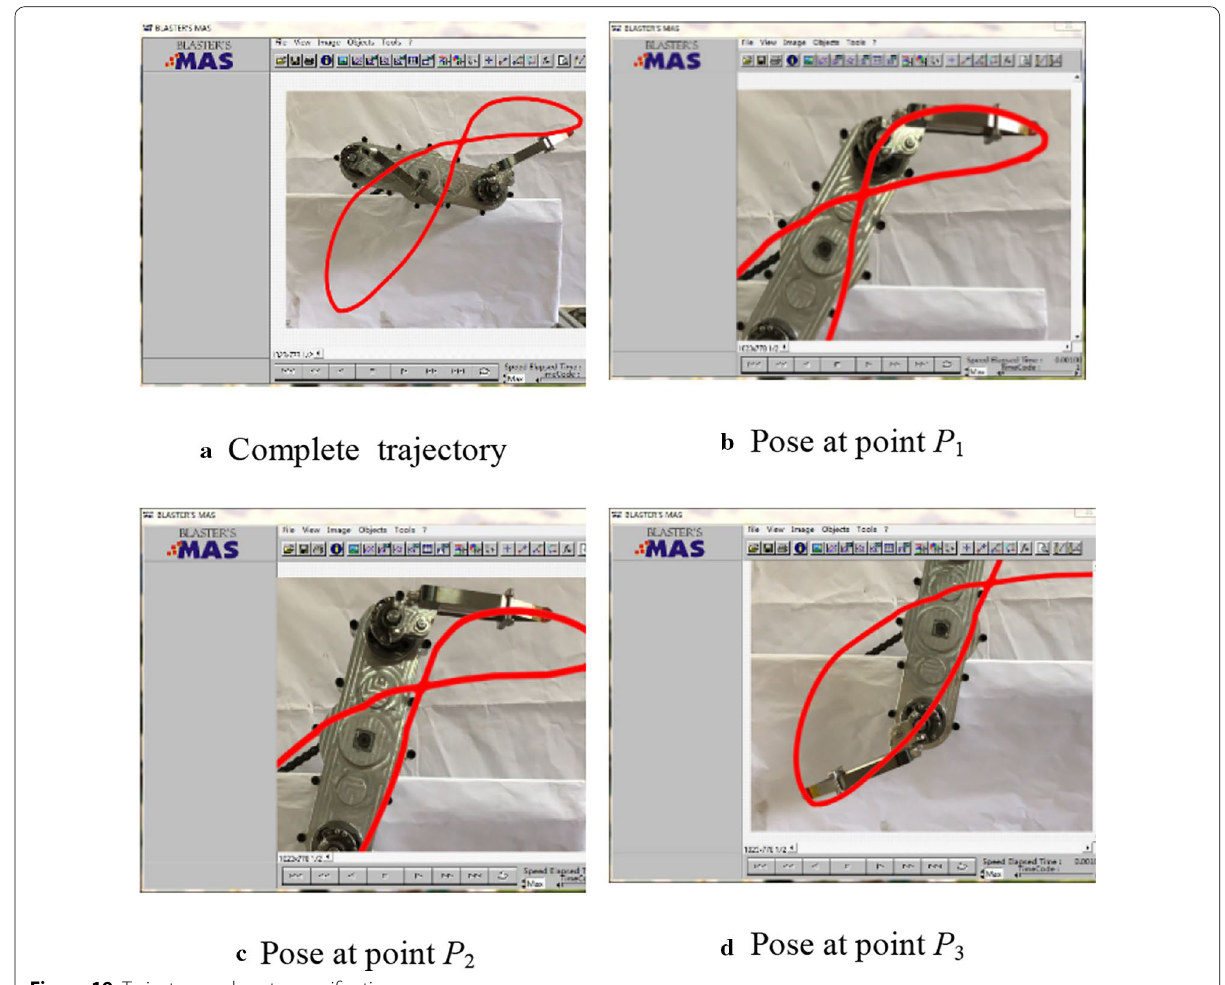
Figure 19 Trajectory and posture verification